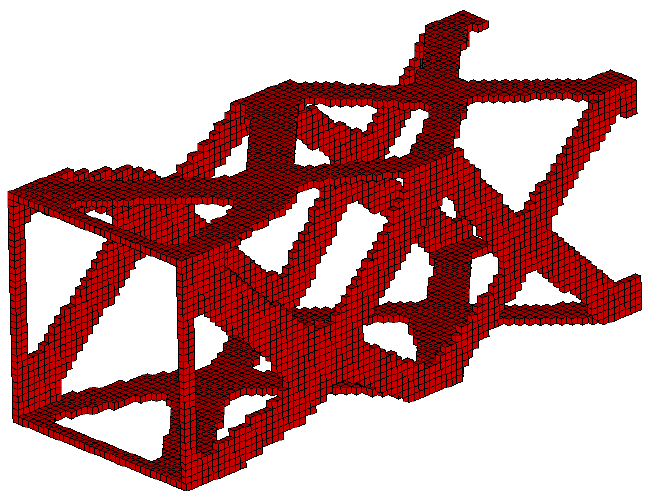
Figure 29. The final topology for the box tube for volume fraction κ = 0.4 .